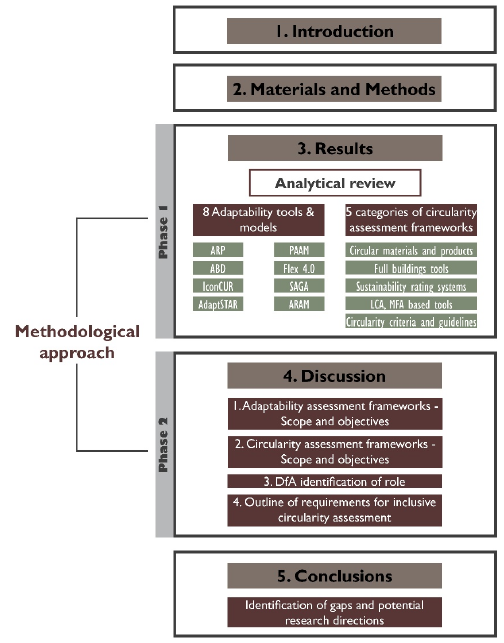
Figure 1. Research design and paper structure.